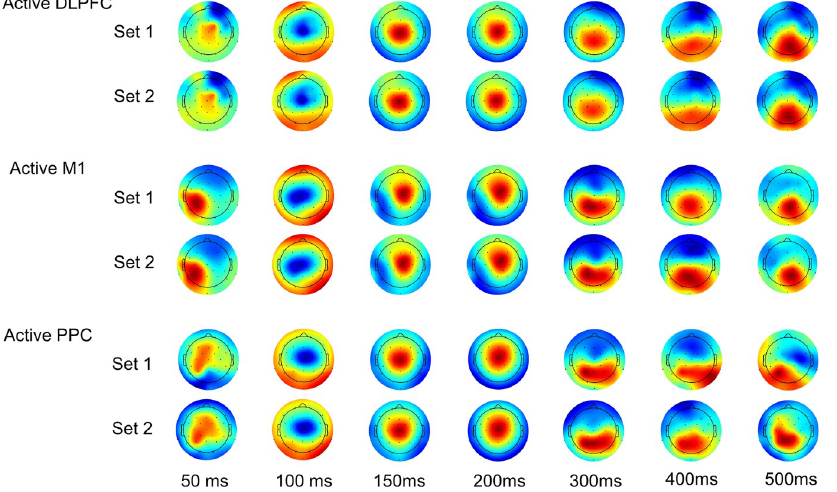
Fig 2. Group-averaged topographical distributions for active stimulation. Plots are shown for every 50 ms from 50 to 500 ms. Each set of plots is the average from a set of 75 randomly selected trials from each